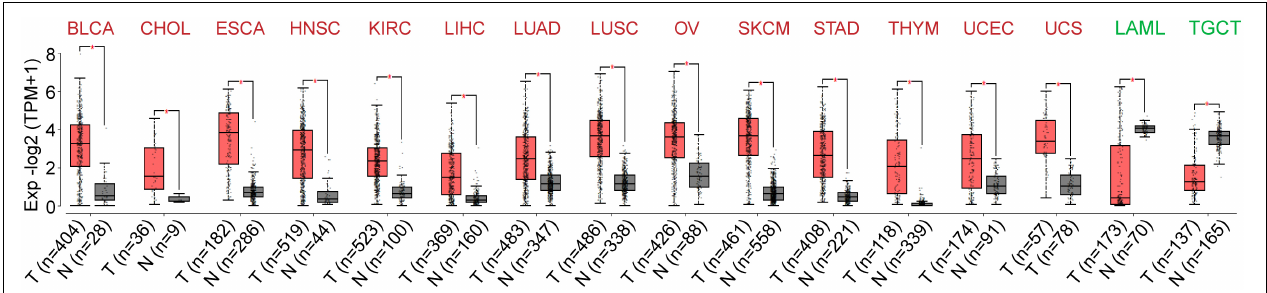
FIGURE 1 | The expression of double homeobox A pseudogene (DUXAP) pattern across pancancer. DUXAP8 expression was dysregulated in several cancer types, and elevated in the bladder urothelial carcinoma (BLCA), cholangiocarcinoma (CHOL), esophageal carcinoma (ESCA), head and neck squamous cell carcinoma (HNSC), kidney renal clear cell carcinoma (KIRC), liver hepatocellular carcinoma (LIHC), lung squamous cell carcinoma (LUSC), ovarian serous cystadenocarcinoma (OV), skin cutaneous melanoma (SKCM), stomach adenocarcinoma (STAD), thymoma (THYM), uterine corpus endometrial carcinoma (UCEC), and uterine carcinosarcoma (UCS). However, the downregulated DUXAP8 expression was observed in the low DUXAP8 TPM in acute myeloid leukemia (LAML) and testicular germ cell tumor